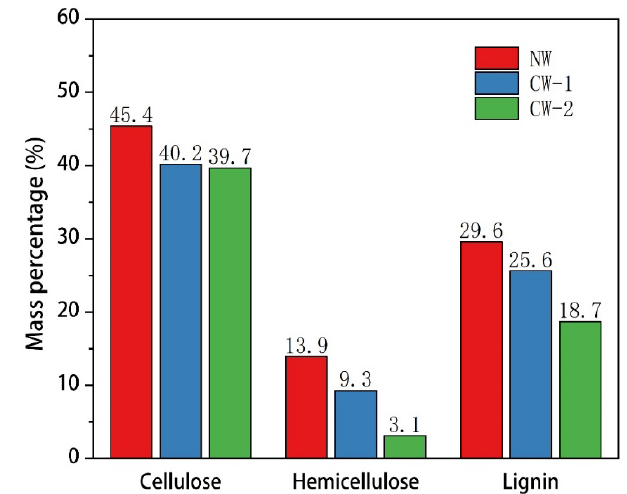
Figure 6. Cellulose, hemicellulose, and lignin contents of NW and CW.